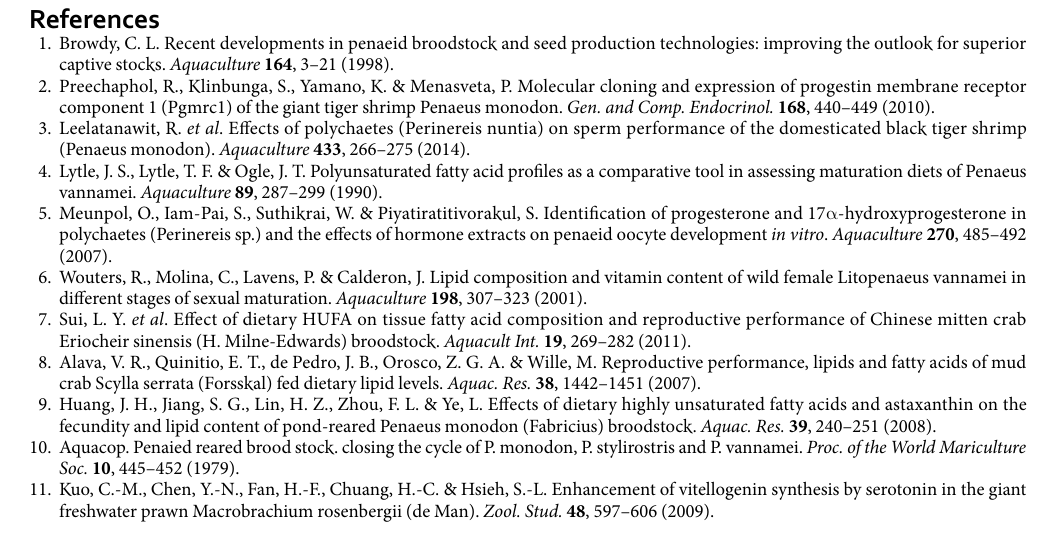
Quantitative real-time PCR (qPCR) validation of selected genes. (Table 2). We followed the previously published protocol 16 . Briefly, 15 μ g of total RNA were treated with RQ1-RNase-free DNase (Promega, USA) to eliminate contamination of genomic DNA. The first strand cDNA were synthesized from 1.5 µ g of DNase-treated total RNA using an ImProm- II TM Reverse Transcription System Kit (Promega, USA) according to manufacturer’s instruction. Concentration and quality of the first strand cDNA were examined by Nanodrop UV (OD 260 /OD 280 ). The cDNA of individual ovaries of black tiger shrimp from different time points were used as template. Each reaction was performed in a total volume of 20 µ L containing 2x iQ ™ SYBR ® Green Supermix (Bio-RAD, USA), 0.2 µ g of cDNA template, 0.2 µ M of primer pair. Cycling param- eters were 95 °C for 2 min 30 s, followed by 40 cycles of 95 °C for 30 s, 58 °C for 20 s and 72 °C for 30 s. To ensure specificity of PCR products, melting curve analysis was performed from 55 °C to 95 °C with continuous fluores- cence reading every 0.5 °C increment. The housekeeping gene Elongation factor 1 alpha ( EF-1 α ) was used as an internal control 60 . All qPCRs were performed in three biological replications ( n = 3 ). For construction of the standard curve for each transcript, a plasmid containing the transcript was con- structed by cloning the PCR product of the transcript into a pGEM-T easy vector (Promega, USA). The resulting vector was transformed into E . coli JM109. The plasmid was extracted and used as the template for construction of the standard curve by 10-fold serial dilutions (10 3 –10 8 copy numbers). Expression levels between feed groups were statistically tested by t-test (p < 0.05), and those among different time points post ablation of the same feed group were statistically tested by ANOVA followed by Duncan method (p < 0.05).